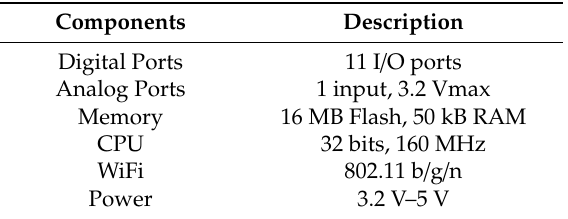
Figure 8. MovED Components. ( a ) NFC I2C module, ( b ) SoC, ( c ) Feedback red, green and blue (RGB) light-emitting diode (LED) ( d ) haptic vibration motor ( e ) battery charger ( f ) battery. Table 1. SoC